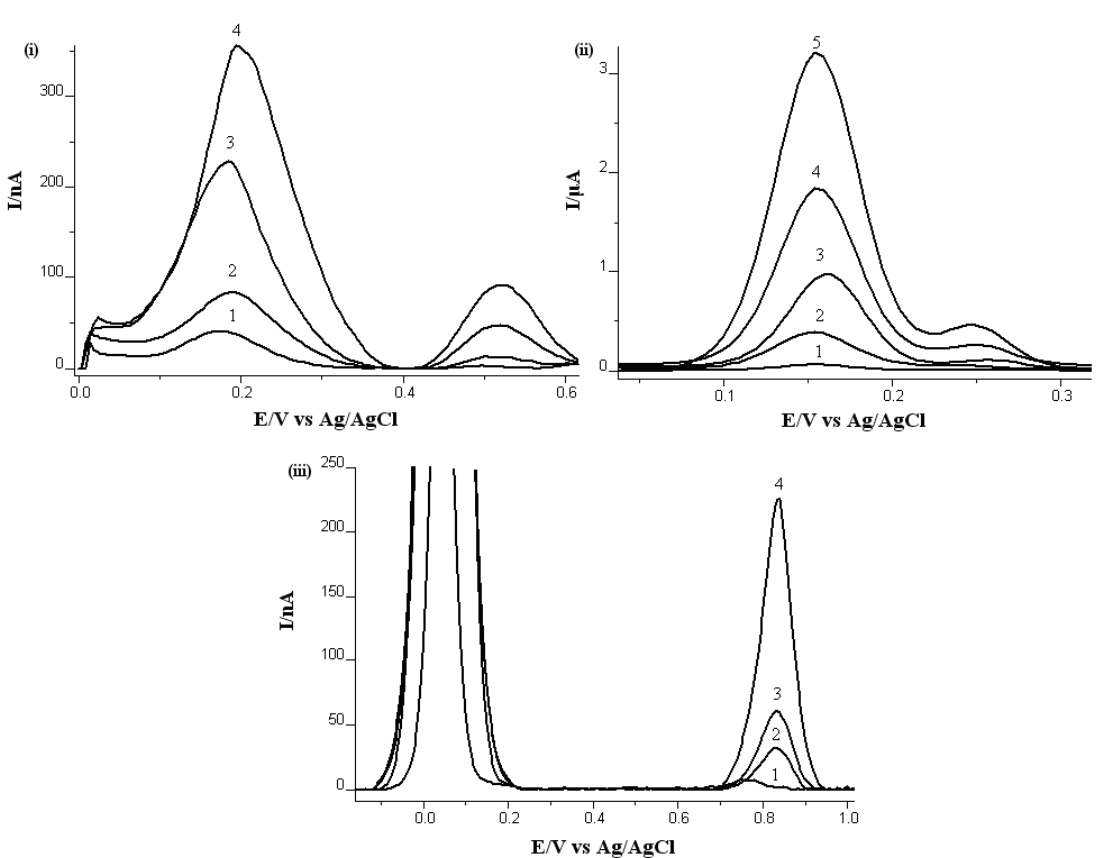
Figure 3. DPV voltammograms. Dependence of the phenolic acid concentration on the appearance of second anodic peaks. (i) gallic acid 1. 5×10 -6 mol L -1 , 2. 10 -5 mol L -1 , 3. 2.5×10 -5 mol L -1 , 4.5×10 -5 mol L -1 , (ii) caffeic acid 1. 10 -6 mol L -1 , 2. 5×10 -6 mol L -1 , 3. 10 -5 mol L -1 ,